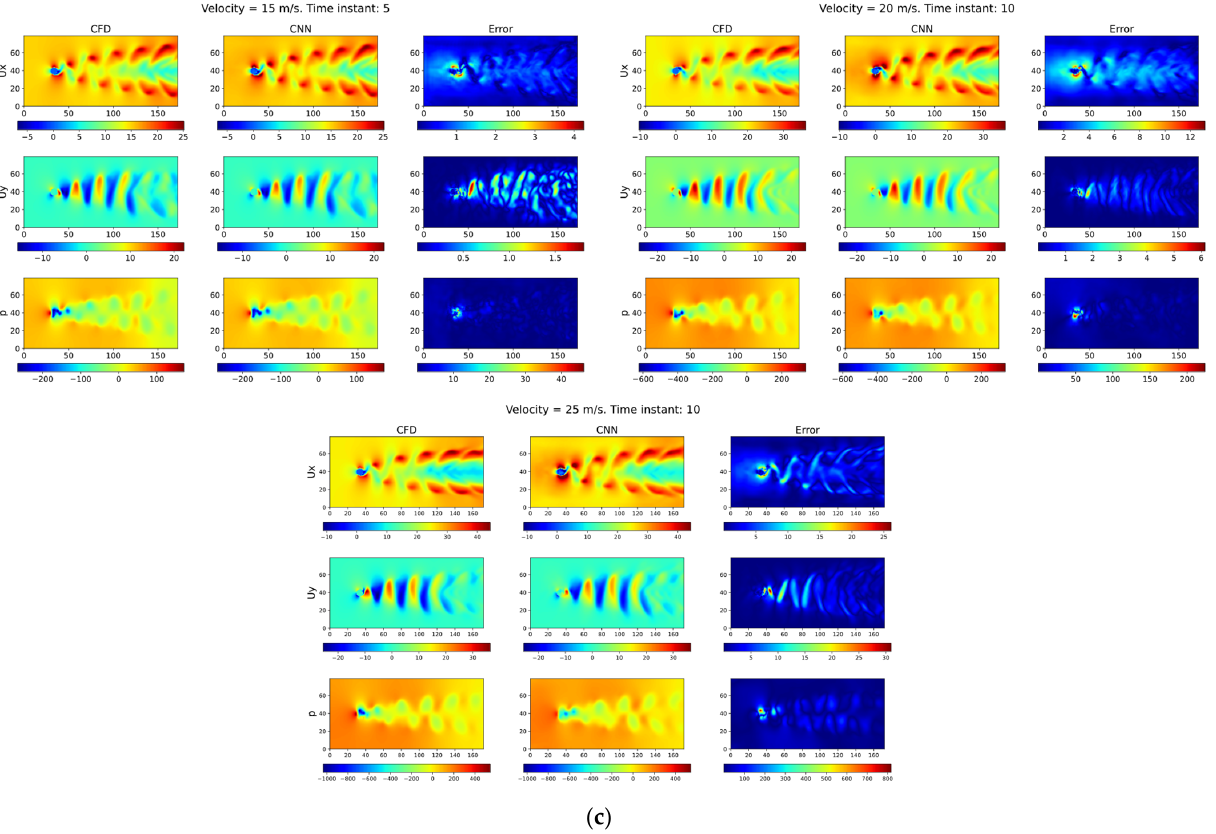
Figure 7. Results of the predictions obtained using the CNN for 5, 10, 15, 20 and 25 m/s at ( a ) the first time instant, ( b ) the fifth time instant and ( c ) the tenth time instant.